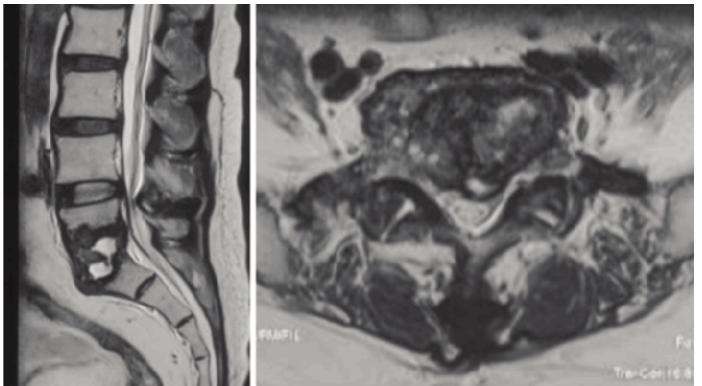
Magnetic resonance imaging (MRI) T2 weighted sagittal view showed cystic lesions without adjacent marrow oedema under the Fig. 2: irregular end plates of L5 and S1.